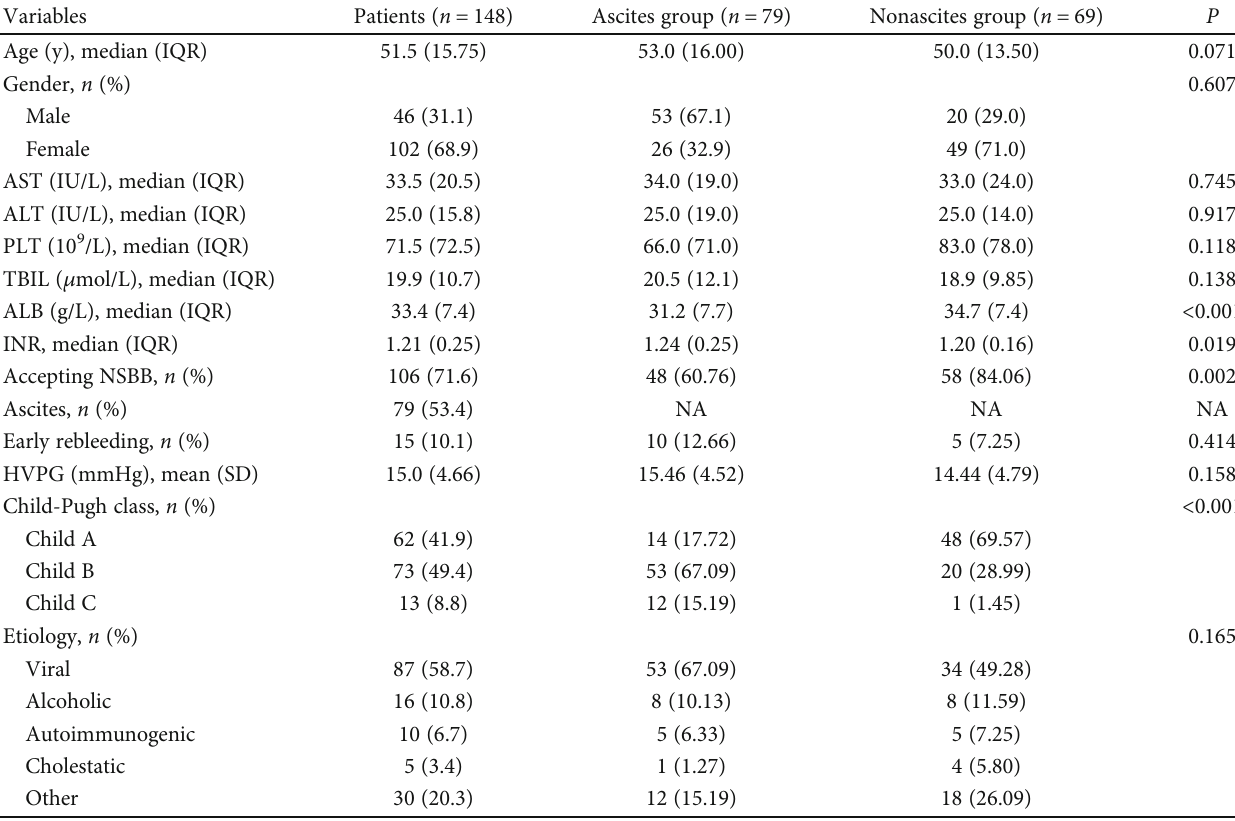
Table 1: Clinical characteristics of the studied patients.